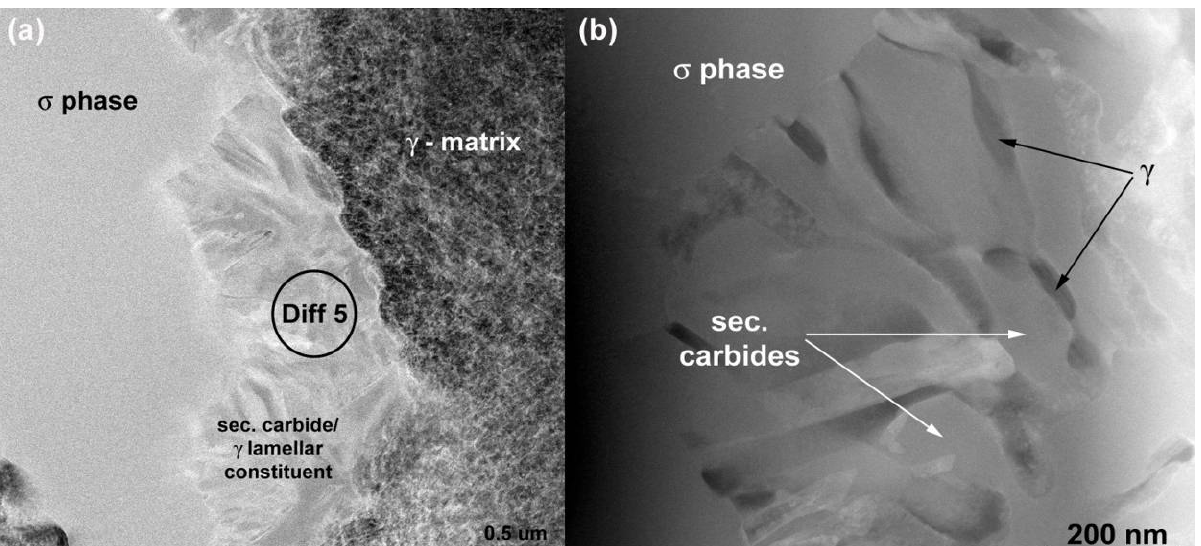
Figure 11. Microstructure of lamellar secondary carbide/ γ constituent